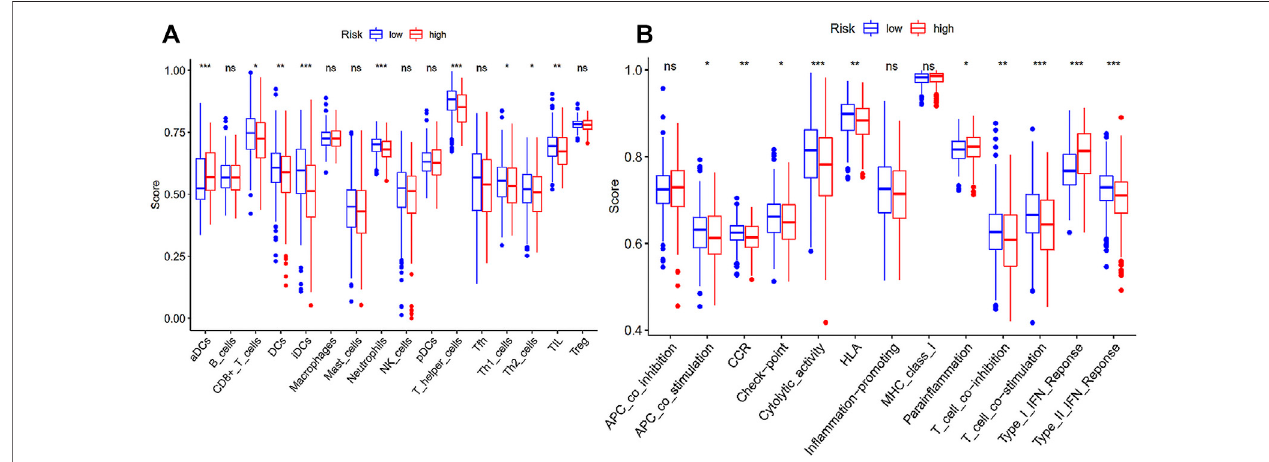
FIGURE 4 | Immune status between high- and low-risk group. (A) Scores of 16 immune cells; (B) Scores of 13 immune-related functions; * p < 0.05; ** p < 0.01; *** p <